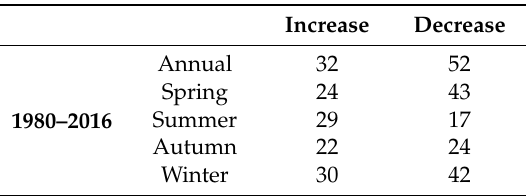
Figure 9. Same as Figure 8b, but for seasonal. 3.4. The Impacts of Emission and Meteorology on Haze Days After a comprehensive analysis of the trend in HDs during different historical periods, we are now trying to explore the potential relationships between inter-annual variation in HDs and the changes in the emissions and meteorological elements. Figures 7 and S3–S6 have demonstrated that the calculated trends in HDs over the SCC region are dominated by SCB. Meanwhile, as has been indicated, the number of HDs in winter contributed more than 50% of annual HDs (see Figure 4); hence we focus our analysis on the basic of annual and winter in SCB. Figure 10a,b showed the annual